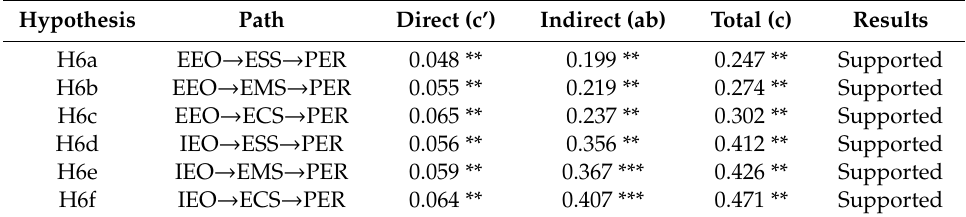
Table 6. Summary results of mediation